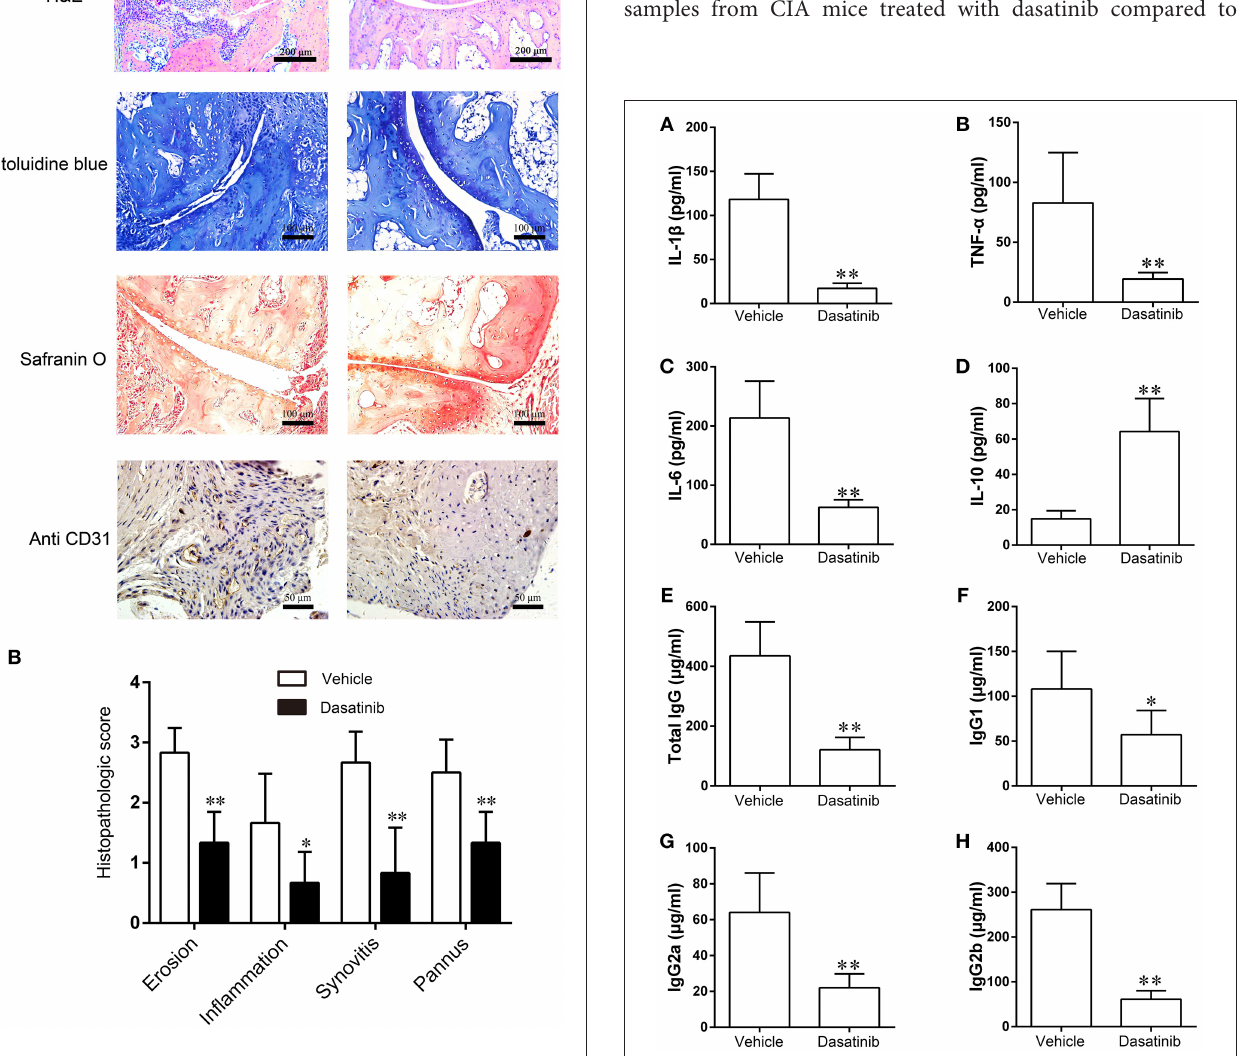
FIGURE 4 | The levels of proinflammatory cytokines including IL-1 β (A) , TNF- α (B) , IL-6 (C) , and anti-inflammatory cytokine IL-10 (D) , anti-mouse CII antibodies including total IgG (E) , IgG1 (F) , IgG2 (G), and IgG2b (H) in serum samples of CIA mice were measured using ELISA. * P < 0.05, ** P < 0.01 vs. vehicle group ( n = 6 per